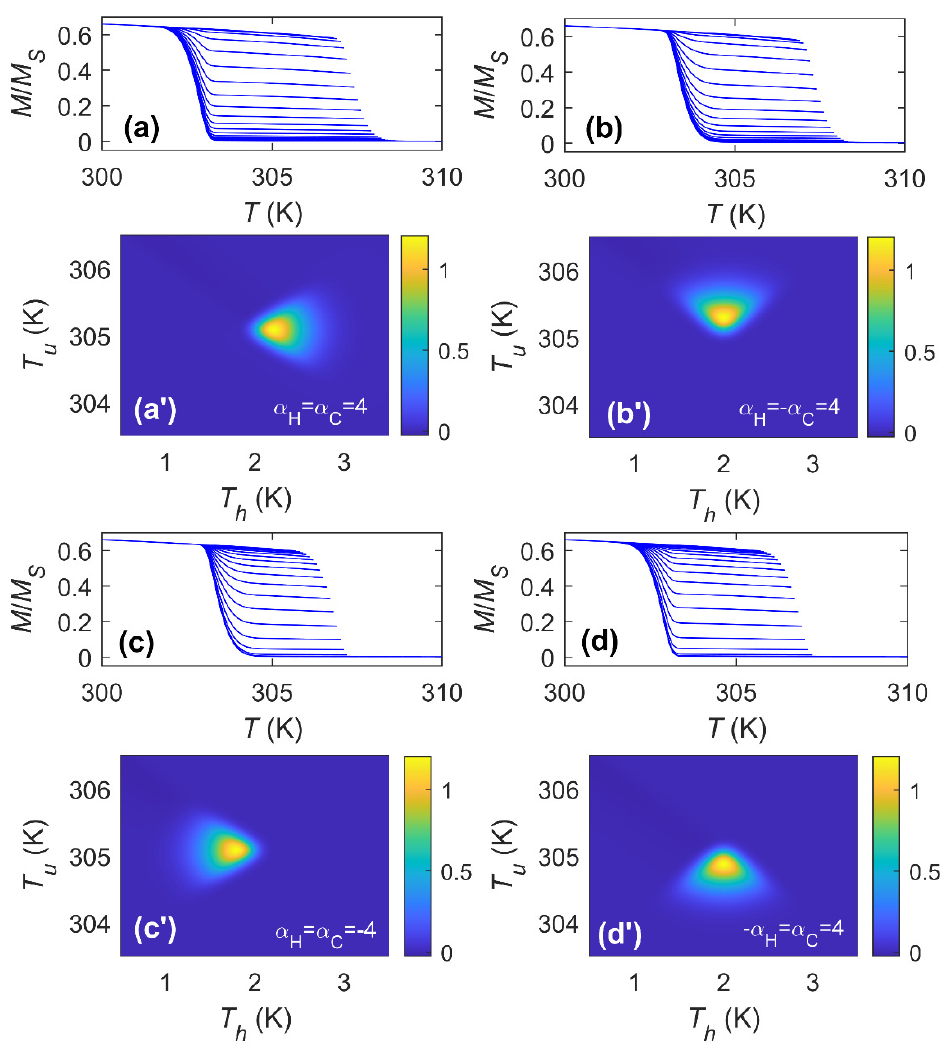
Figure 8. Cooling first order reversal magnetization curves and associated TFORC distributions with (cid:2022) (cid:3009) = (cid:1846) (cid:3047),(cid:3020)(cid:3021) + 2 K , (cid:2022) (cid:3009) = (cid:1846) (cid:3047),(cid:3020)(cid:3021) − 2 K , (cid:2026) (cid:3009) = (cid:2026) (cid:3004) = 0.5 K and different skewness factor combinations: ( a ) – ( a’ ) (cid:2009) (cid:3009) = (cid:2009) (cid:3004) = 4 , ( b )–( b’ ) (cid:2009) (cid:3009) = −(cid:2009) (cid:3004) = 4 , ( c )–( c’ ) (cid:2009) (cid:3009) = (cid:2009) (cid:3004) = −4 and ( d )–( d’ ) −(cid:2009) (cid:3009) = (cid:2009) (cid:3004) = 4 .